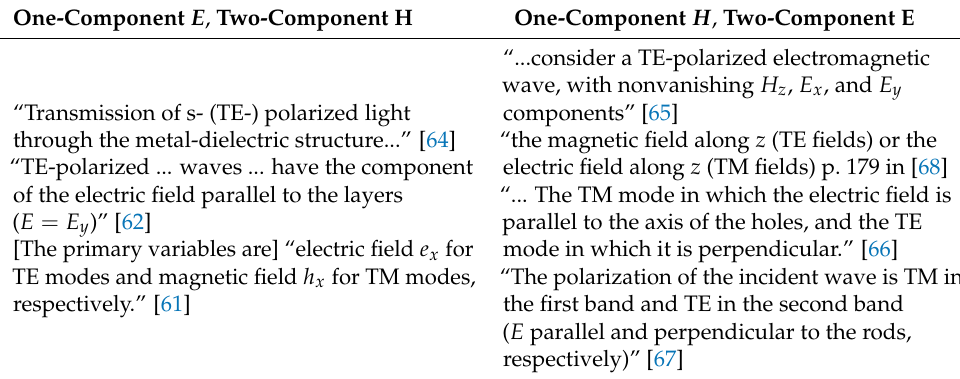
Table 2. A few representative quotes on TE/TM modes. Table adapted by permission from Springer Table 8.2 in [1]